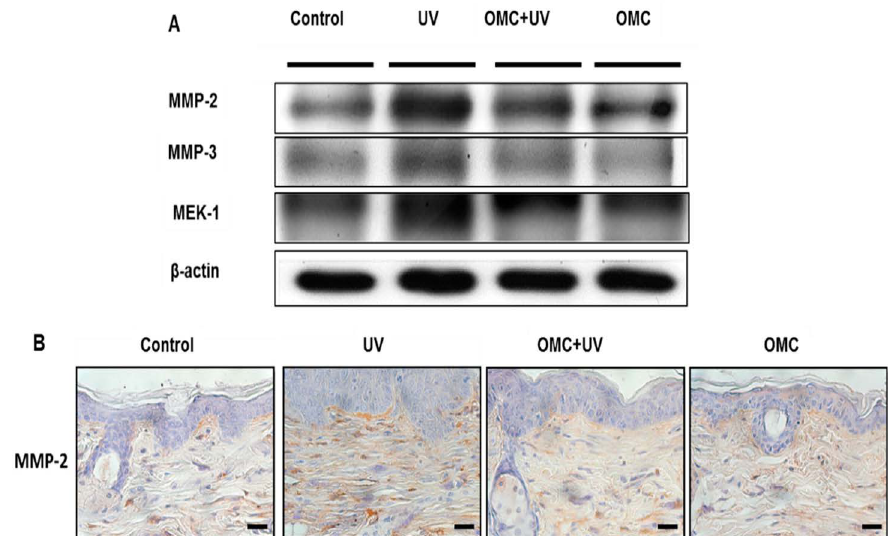
Figure 4. Effects of OMC on MMPs and MEK-1 expression in UV-irradiated SKH-1 hairless mice. ( A ) Immunoblotting results showed that UV-induced upregulation of MMP-2, MMP-3, and MEK-1 expression was inhibited by OMC; ( B ) The immunohistochemical results showed that UV-induced upregulation of MMP-2 expression was inhibited by OMC. Scale bar = 20 µ m.